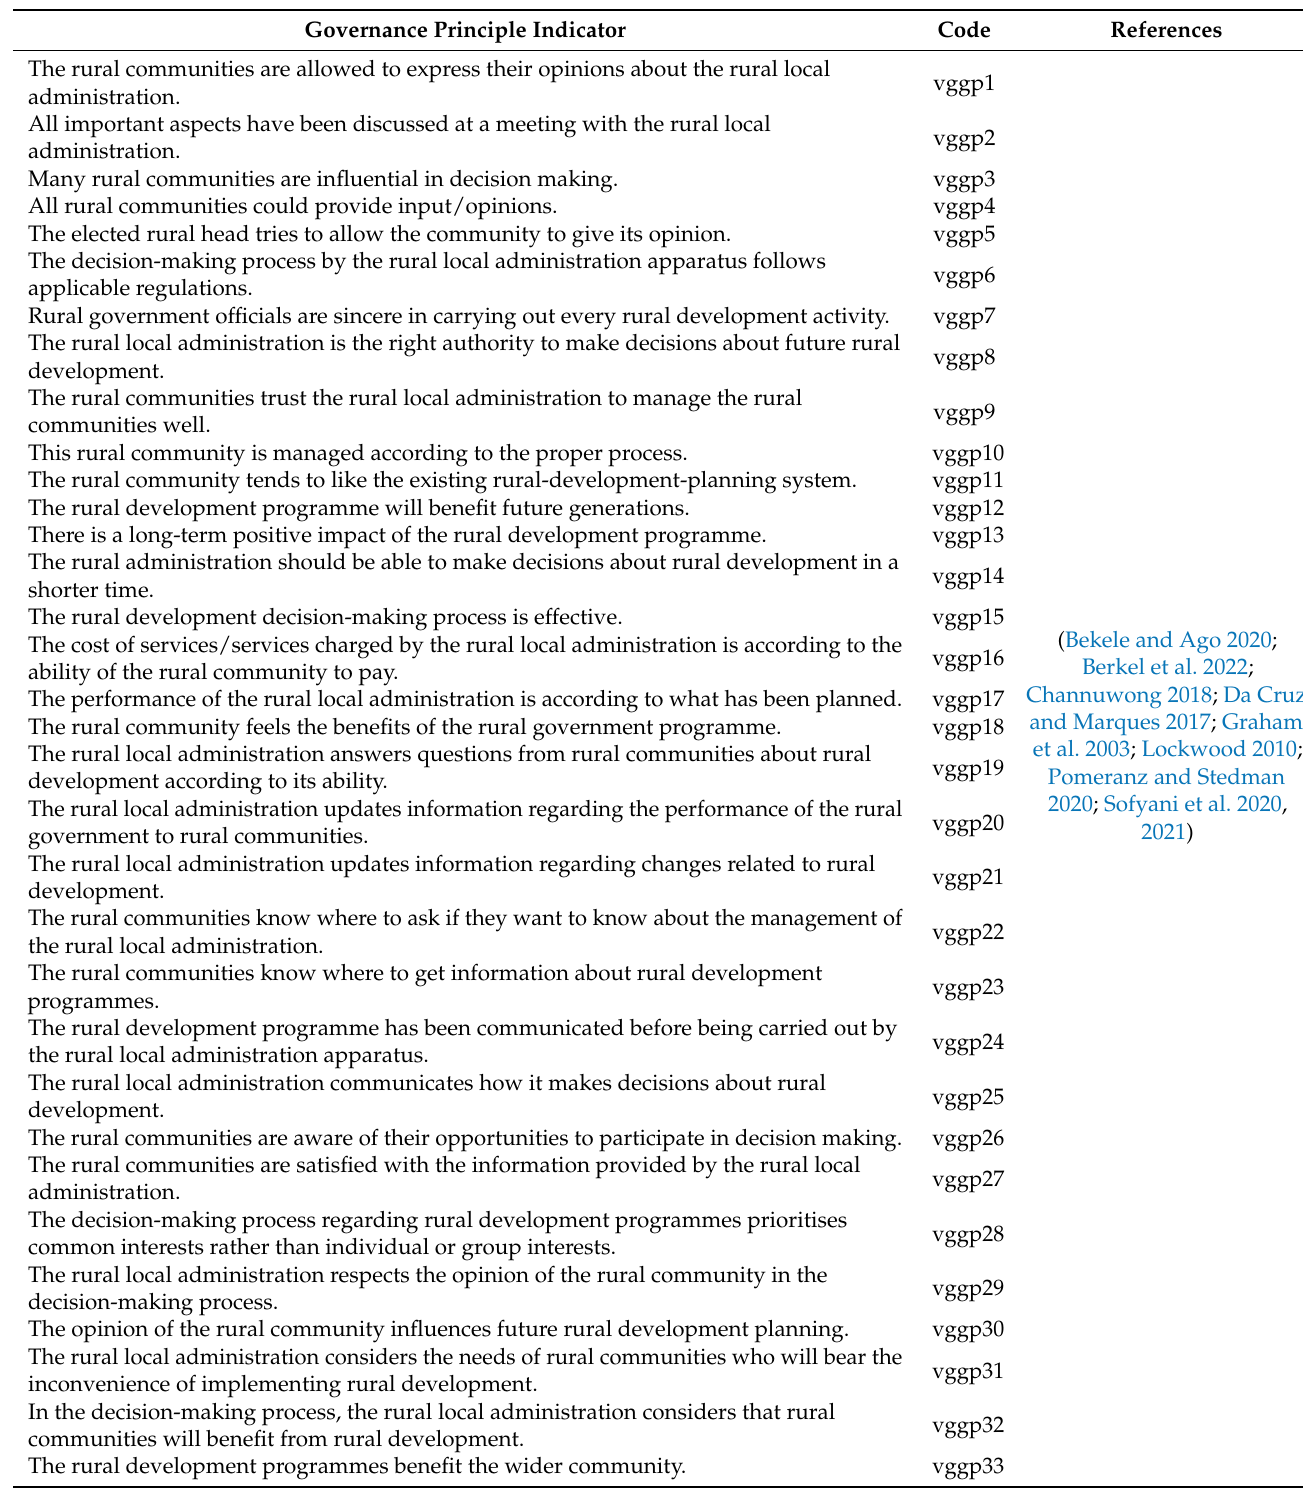
Table 1. Indicator of governance